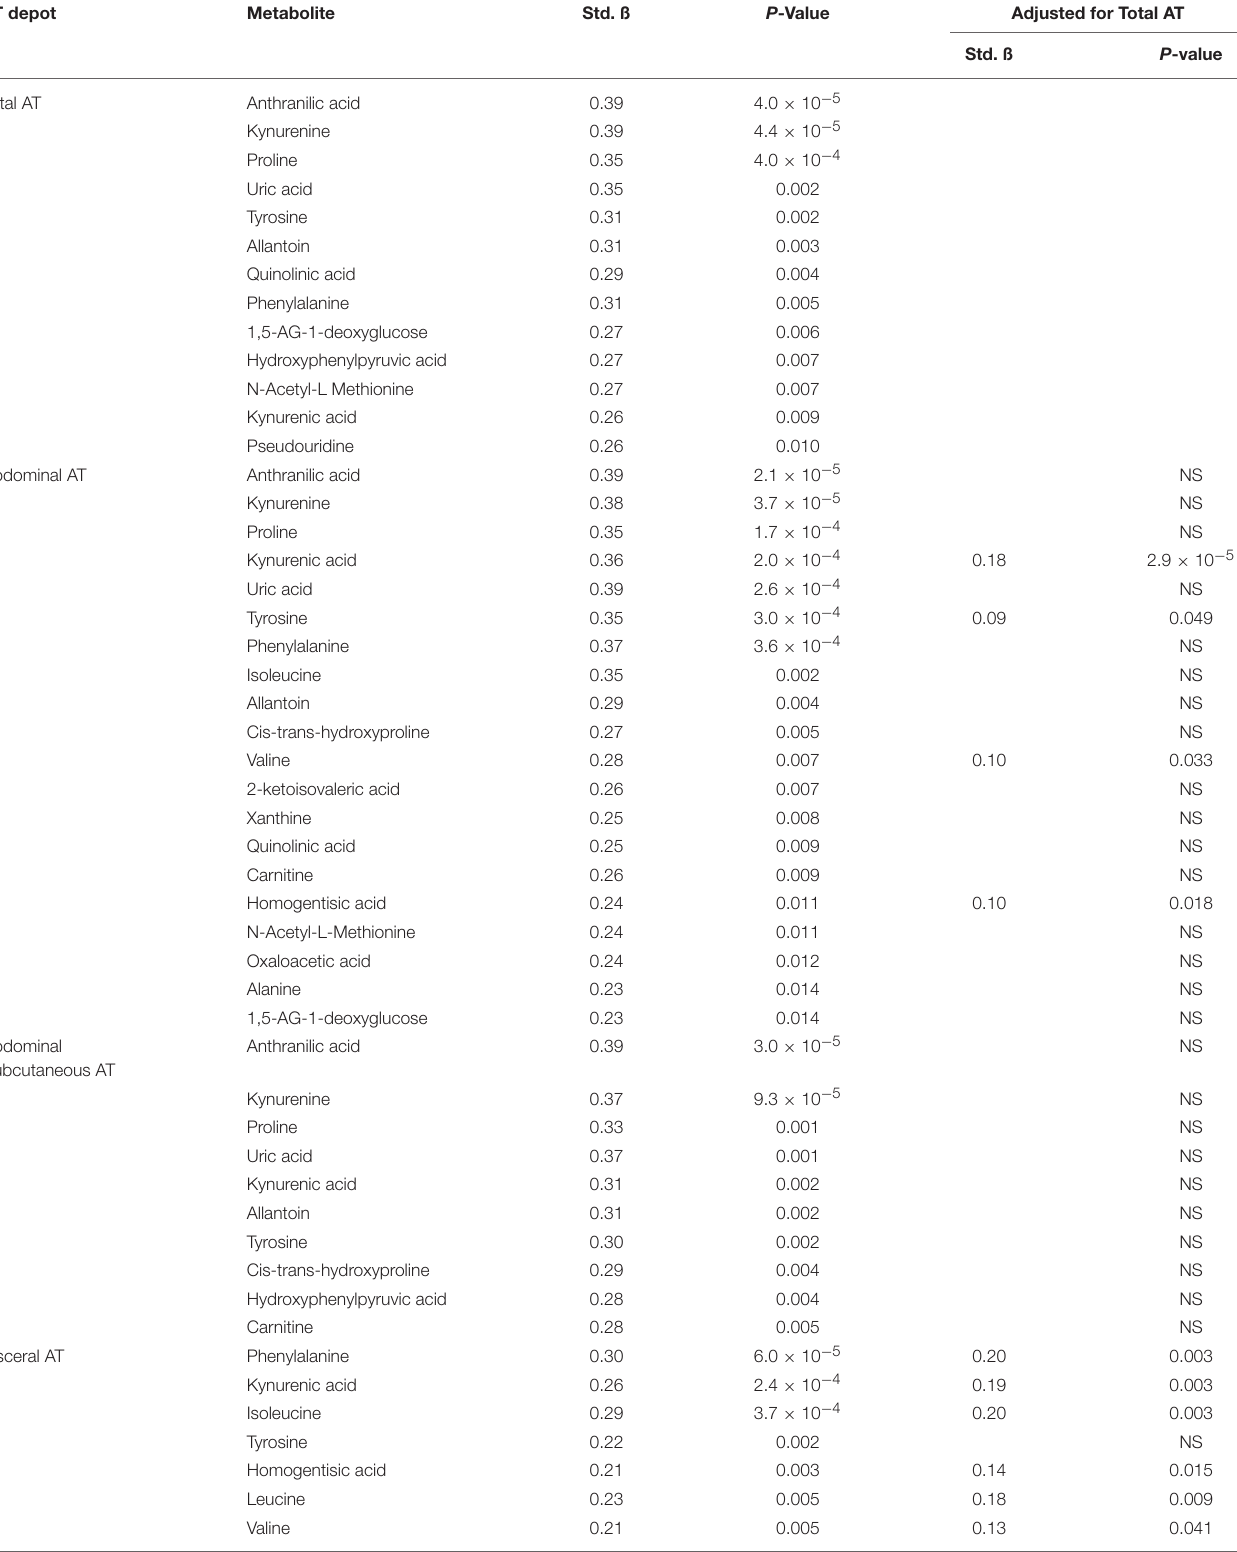
TABLE 3 | Cross-sectional associations between metabolites and AT depots. AT